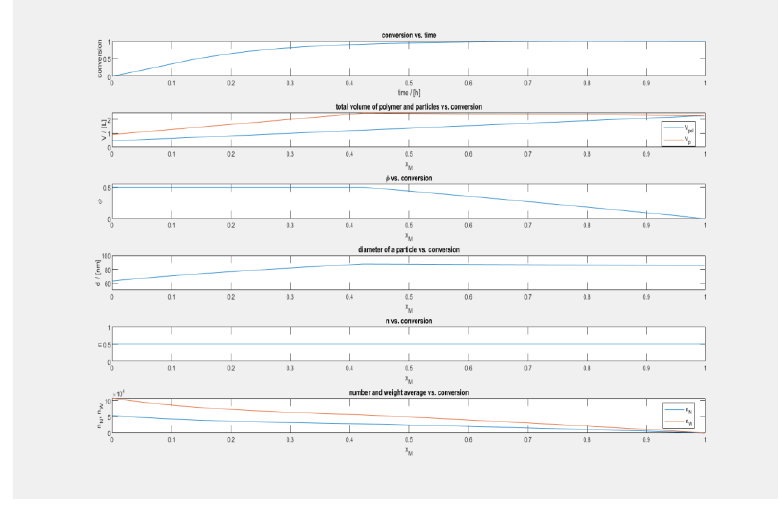
Figure 4. Stress – strain curves of HDPE-HA